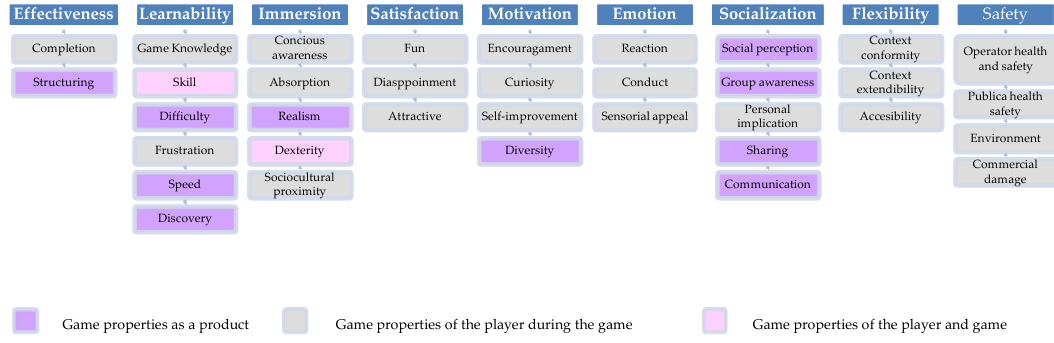
etc. Figure 1. ISO/IEC 2501-3/2009: internal and external quality games aspects. The classic ex-ante videogame evaluation metrics [78,79] focus on internal evaluation processes centered on the design (game mechanic, game engine) and on the architecture of the game (game interface, narrative game and and plot development). Other types of more recent external metrics have focused on aspects external to the design and architecture of the videogame [80–82].